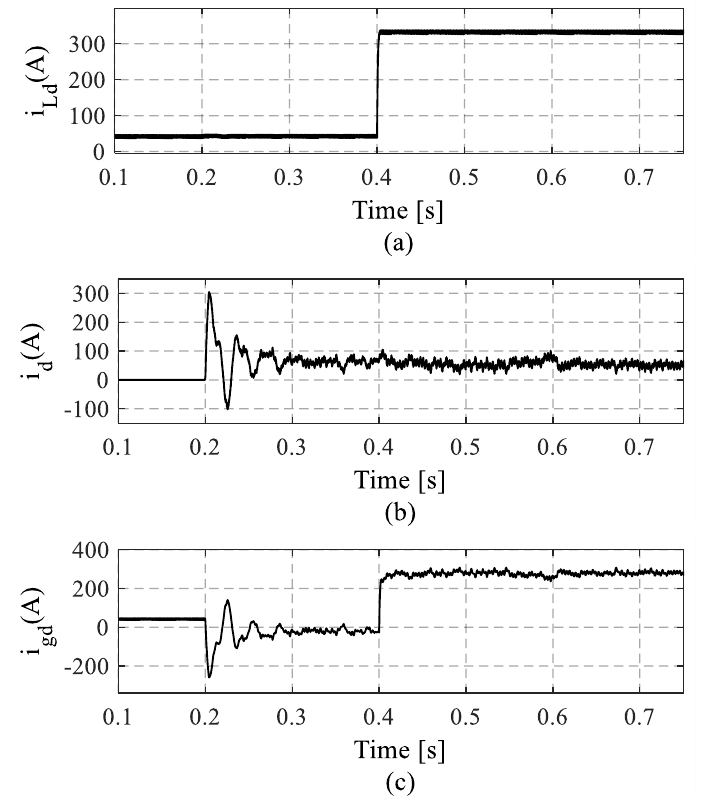
Figure 8. Active current components of the STATCOM model: ( a ) d component of load current; ( b ) d component of MMC current; and ( c ) d component of grid current.